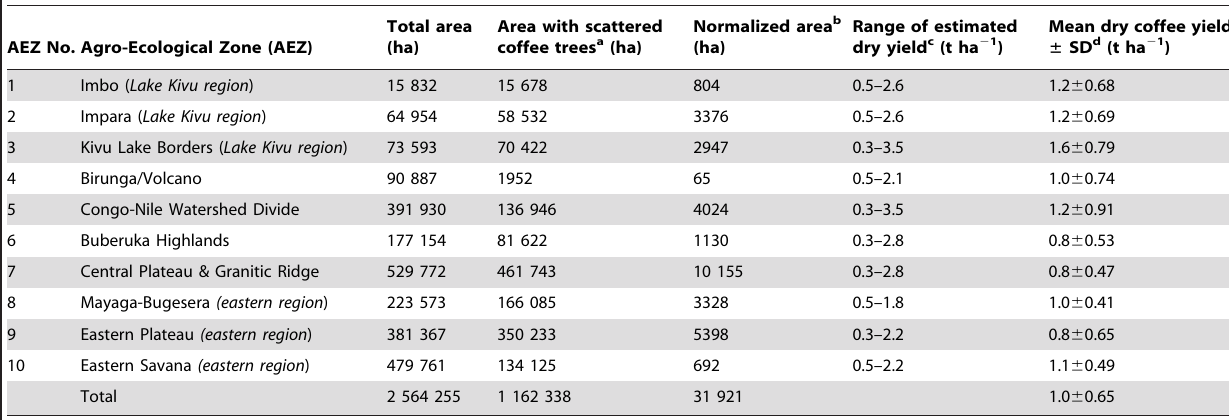
Table 2. Distribution of Arabica coffee areas (ha) and yields (t ha 2 1 ) calculated from the coffee database for 2005 for the ten agro- ecological zones of